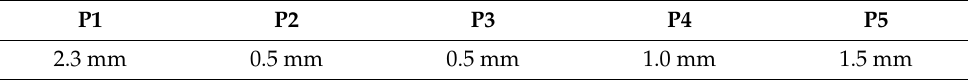
Figure 15. The manufactured fairing.